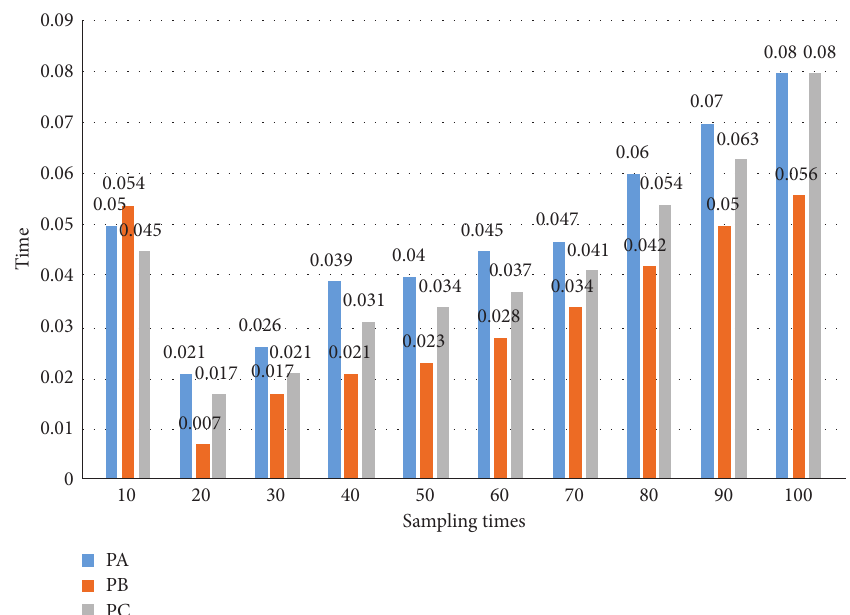
Figure 9: The relationship between the number of samples of the algorithm RANSAC and the running